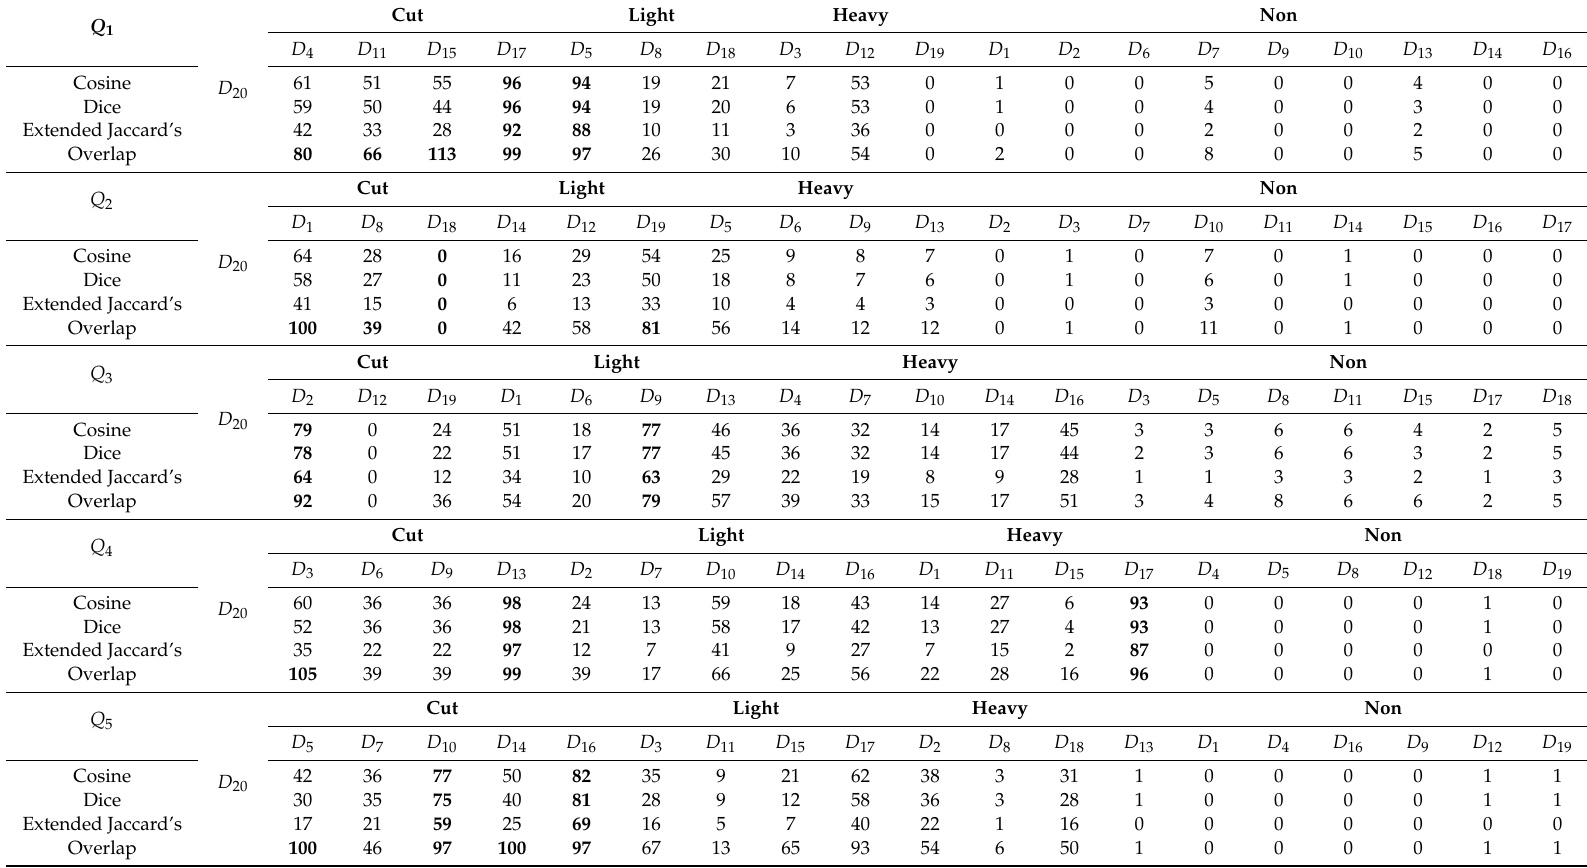
Table 6. Texts similarity results sorted as Near copy (cut), Light revision (light), Heavy revision (heavy), Non-plagiarism (non) (results are given in